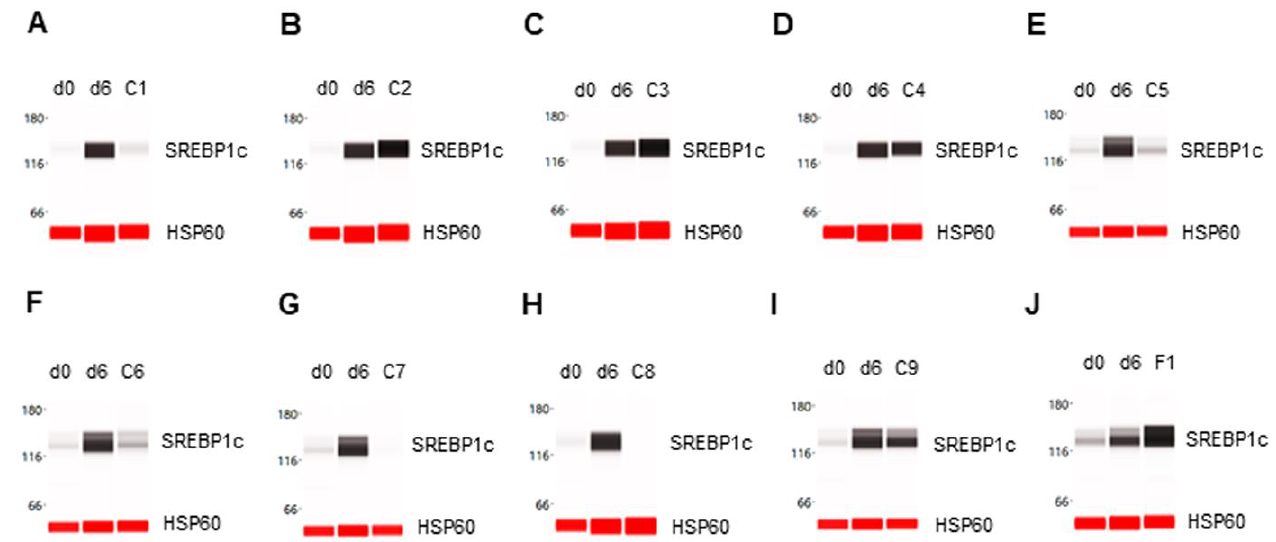
Figure 2. Enhancement of SREBP1c expression in differentiating preadipocytes. Expression level of SREBP1c in preadipocytes on d0, d6 post-differentiation, and d6 post-differentiation in the presence of ( A ) berberine (C1), ( B ) luteolin (C2), ( C ) resveratrol (C3), ( D ) fisetin (C4), ( E ) quercetin (C5), ( F ) fucoidan (C6), ( G ) EGCG (C7), ( H ) hesperidin (C8), ( I ) curcumin (C9), or ( J ) F1 composition. β -actin served as a loading control. The protein expression level was measured using multiplexed capillary Western immunoassays. Molecular markers in kilodalton (kDa) are displayed on the left of the capillary Western immunoassay data.